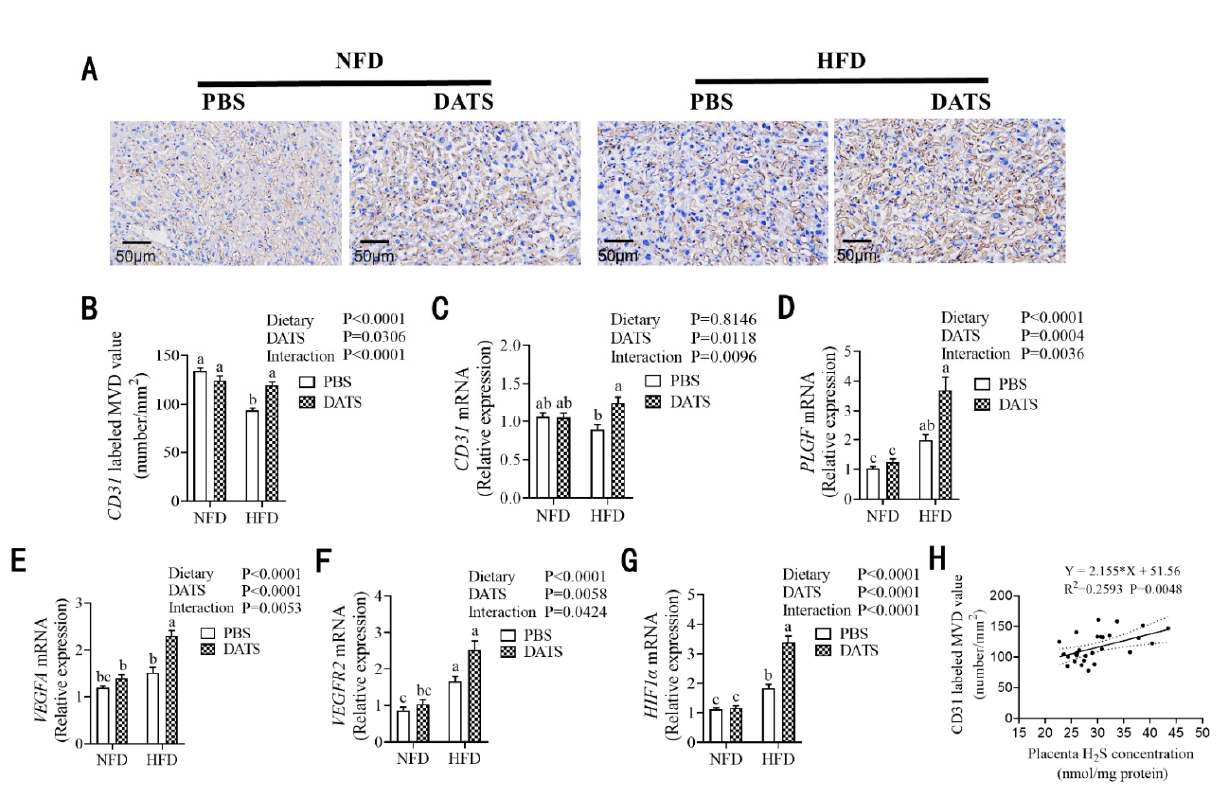
Figure 4. DATS treatment can improve placental angiogenesis. ( A ) Immunohistochemical analysis for placental CD31 staining in the labyrinth zone of the placenta (brown) ( n = 8–11 placentas/group), scale bar 50 μm. ( B ) Expression of CD31 protein in the labyrinth zone ( n = 8–11 mice/group). ( C – G ) Relative CD31, PLGF, VEGFA, VEGFR2 and HIF1 α mRNA expression ( n = 9–11 mice/group). ( H ) Correlation analysis of H 2 S levels with expression of CD31 protein in the labyrinth zone ( n = 8–11 mice/group). Two-way ANOVA—the values represent the mean ± SEM, p < 0.05 was considered to indicate statistical significance and different letters indicate significant differences.